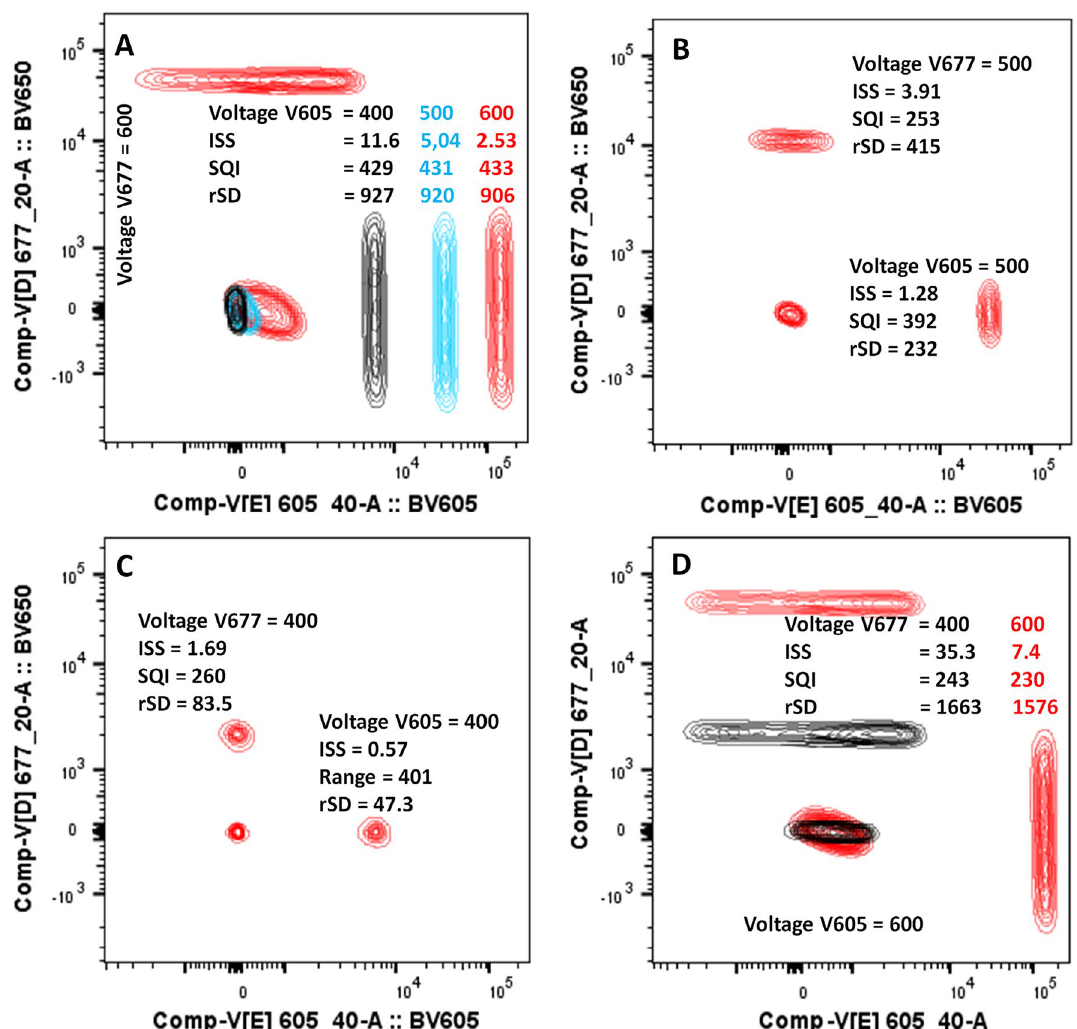
Figure 2. Effect of PMT voltage on ISS: In ( A ), the primary detector (V605) voltage was changed from 600 to 400 V in steps of 100 V. This did not change the rSD and SQI values measuring the spread in the secondary detector (V677). However, the ISS values changed noticeably. In ( A – C ), voltages of both detectors were changed simultaneously to 600 V, 500 V or 400 V respectively. The SQI values remained the same for both detectors in all cases, but the ISS values decreased considerably. In ( D ) only voltage of V677 was lowered which resulted in a huge increase of ISS but SQI remain SQI values are independent of detector gain settings. Our main goal is to quantify spread inde- pendent of detector voltage/gain. The normalization factor was introduced for this reason. We devised this sim- ple experiment to test the accuracy of the normalization factor. Single stained beads were measured with two different PMT voltage sets. The voltage was manipulated to position the positive population to ~ 110,000 MFI or 50,000 MFI in all detectors. The SQI values were the same in both voltage sets, but the ISS values were quite different (Table 3). This observation is possible because SQI does not include any component from the primary detector. When the voltage of detector B was decreased, the spread from fluorochrome X in detector B was reduced, but the intensity of fluorochrome Y, which was used to calculate normalization factor, reduced pro- portionally, rendering SQI values independent of detector voltage. In contrast, when the same data were used to obtain the conventional Spillover Spread Matrices, the lower voltage set showed lower ISS values (Table 3). In another scenario, a series of voltages were applied in which the voltage of the secondary detector was kept constant, but the voltage of the primary detector was changed gradually (Fig. 3A,B). Alternatively, the voltage of the primary detector was kept constant, and the voltage of the secondary detector was changed (Fig. 3C,D). In both cases the SQI values remained the same, however, the ISS values changed considerably. Application of SQI: compare instruments with different dynamic range. To investigate which instrument is the best for running a given panel in terms of spread, we compared the SQI values between a Fusion, Symphony, Quanteon and a CytoFLEX (Table 1). The CytoFLEX showed the lowest number of SQI